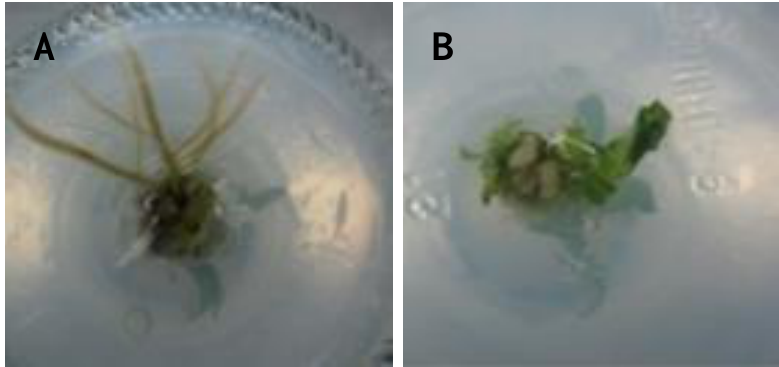
Figure 3: Root induction of axillary bud in MS medium containing different concentrations of NAA after 4 weeks. A) Root induced in 0.2 ppm NAA and B) no roots induced in 0.5 ppm